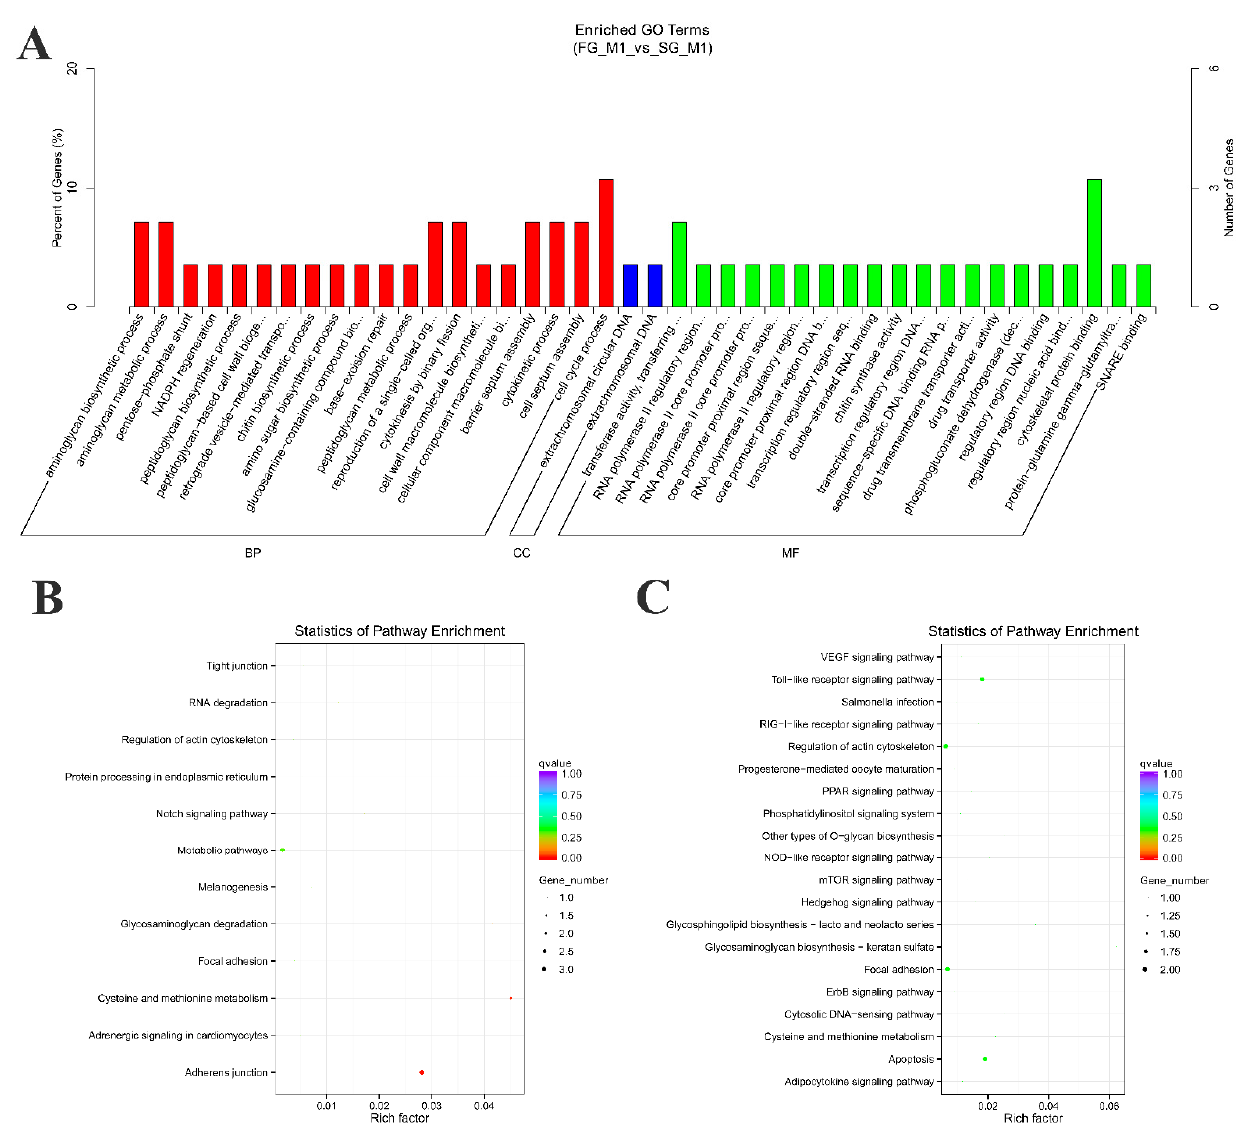
Figure 5. GO and KEGG analysis of DE circRNAs. ( A ) GO analysis of source genes related to DE circRNAs under the theme of biological process (BP), cellular component (CC), and molecular function (MF). ( B ) KEGG analysis of DE circRNAs with source genes. ( C ) KEGG analysis of the target mRNAs of miRNAs sponged by circRNAs.